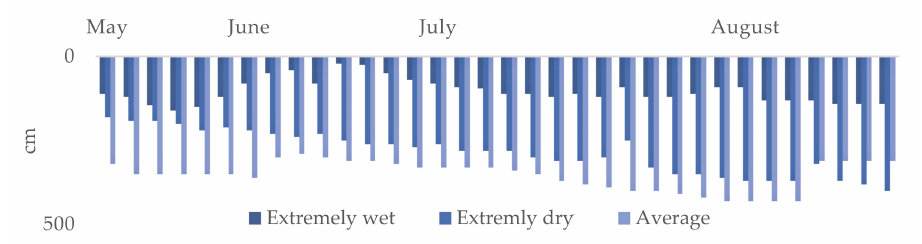
Figure 3. Groundwater levels (cm) during the study